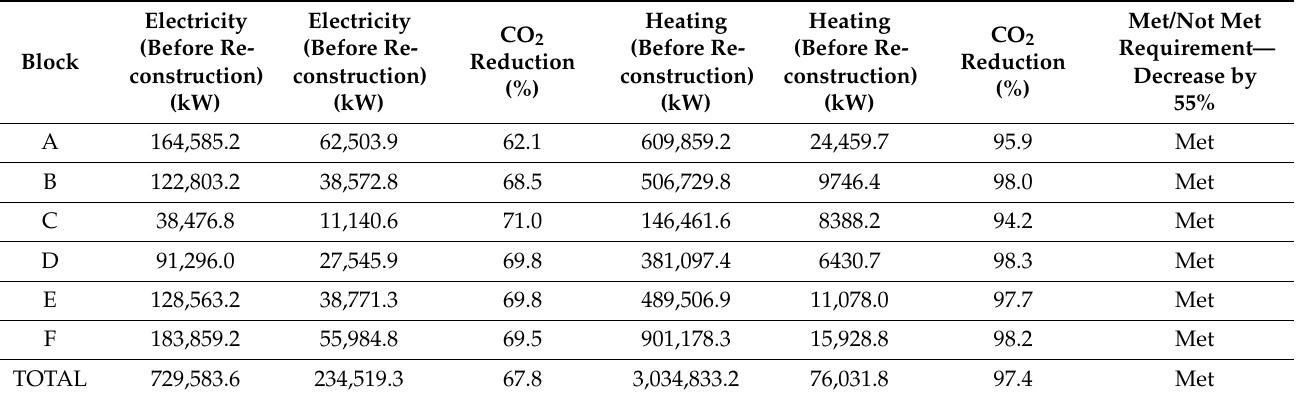
Table 26. Evaluation of CO2 production before and after the reconstruction of the urban area by DB simulations of heating and electricity consumption.